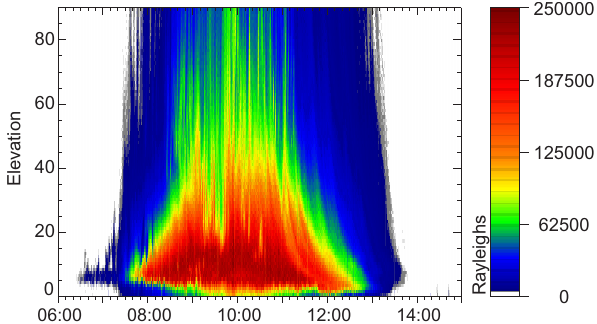
Fig. 2. The time evolution in UT of the 845nm background con- tinuum data from the Longyearbyen Auroral Station MSP on 6 De- cember 2002. The signal is integrated over a 5 ˚A filter. The MSP scans elevation at a fixed azimuth, 135 ◦ from North.